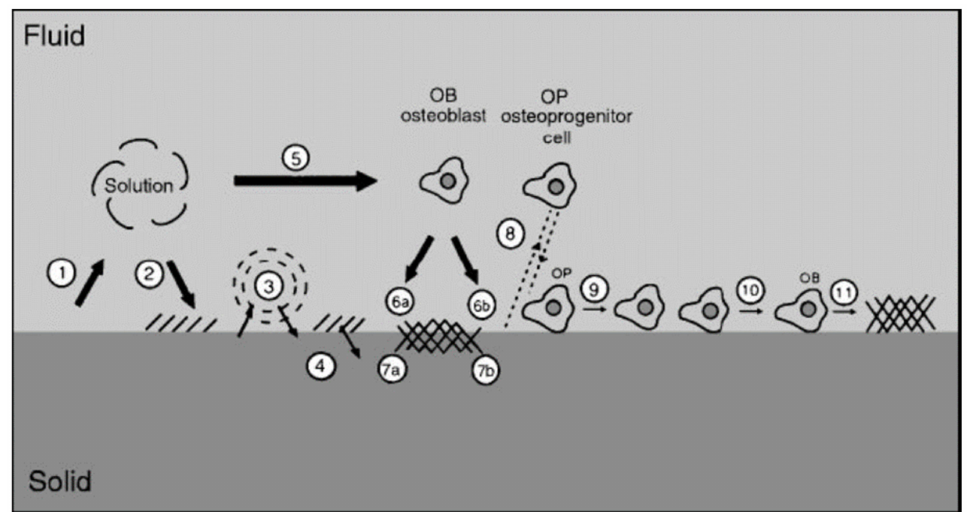
Figure 13. A schematic diagram representing the events which take place at the interface between bioceramics and the surrounding biological environment: (1) dissolution of bioceramics; (2) pre- cipitation from solution onto bioceramics; (3) ion exchange and structural rearrangement at the bioceramic/tissue interface; (4) interdiffusion from the surface boundary layer into the bioceramics; (5) solution-mediated effects on cellular activity; (6) deposition of either the mineral phase (a) or the organic phase (b) without integration into the bioceramic surface; (7) deposition with integration into the bioceramics; (8) chemotaxis to the bioceramic surface; (9) cell attachment and proliferation; (10) cell differentiation; (11) extracellular matrix formation. All phenomena, collectively, lead to the gradual incorporation of a bioceramic implant into developing bone tissue. Reprinted from Ref. [58] with permission.